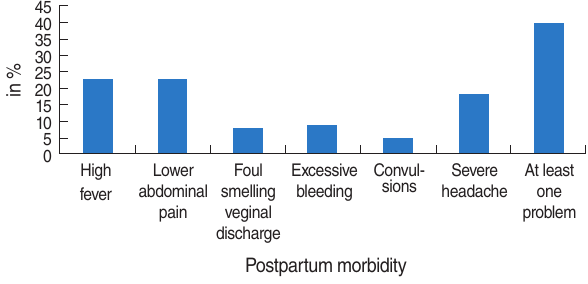
Figure 1. Prevalence of postpartum morbidities among mothers (aged 15-49 years) in rural India,